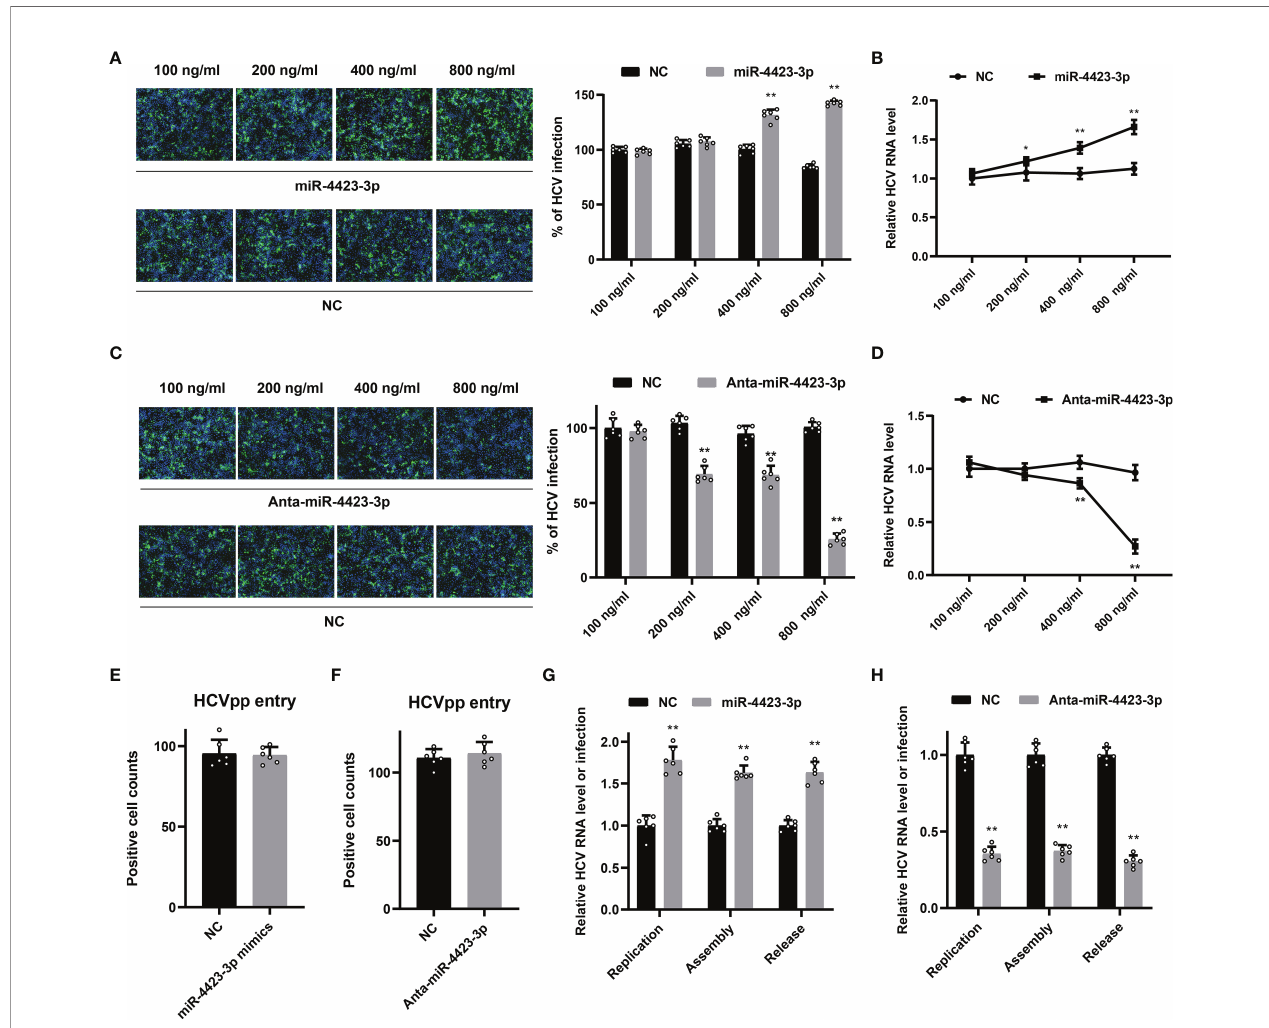
FIGURE 5 | Function of miR-4423-3p on HCV infection. (A, B) Huh7 cells were transfected with indicated concentrations of miR-4423-3p mimics or scramble control and infected with HCVcc (MOI = 0.1) for 6h. Approximately 48 h after infection, HCV infection was analyzed by IF (A) and RT-qPCR (B) . (C, D) Huh7 cells were treated with various concentrations of miR-4423-3p inhibitors or scramble control, followed by infection of HCVcc (MOI = 0.1). Viral infection was also detected by IF (C) and RT-qPCR (D) . Results were shown as % of HCV infection or relative HCV RNA level. **p < 0.01 compared with negative control. (E, F) Huh7 cells were transfected with miR-4423-3p mimics (E) or inhibitors (F) and incubated with HCVpp for 6h. HCV entry ef fi ciency was analyzed by counting the positive cells in respective wells. (G, H) Huh7 cells were treated with miR-4423-3p mimics (G) or inhibitors (H) for 24 h, and then transfected with HCV RNA. Aapproximately 24 h after transfection, parts of the cells were lysed to test intracellular HCV RNA level to evaluate viral replication. Parts of the cells were subjected to three cycles of freeze and thaw to test the intracellular viral infectivity to evaluate viral assembly. Cellular supernatant was collected to determine viral release. Results were shown as relative HCV RNA level or infection. *p < 0.05, **p < 0.01 compared with the negative control